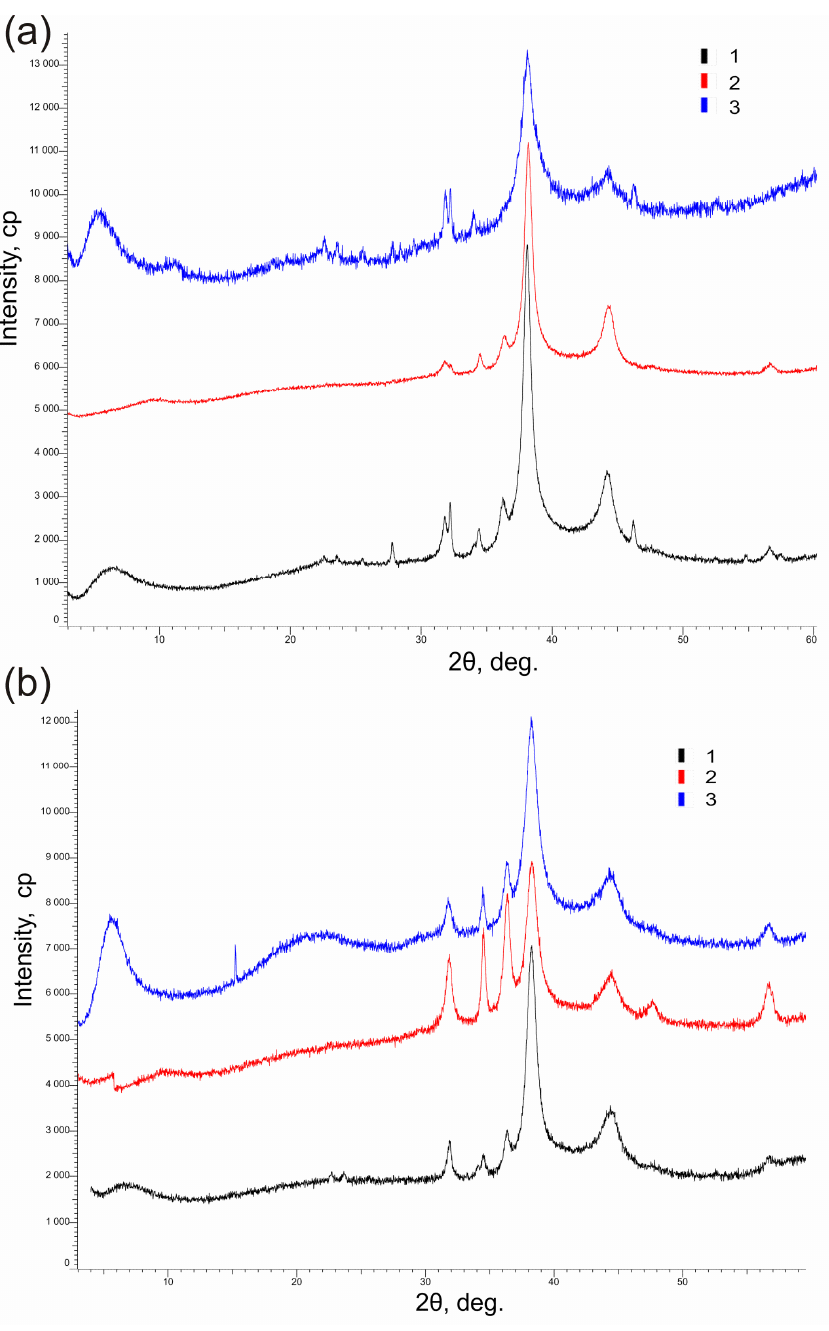
Figure 5. XRD patterns of heterodimers used: ( a ) VM/Ag 0 /ZnO (1), EM/Ag 0 /ZnO (2), Figure 5 . XRD pa tt erns of heterodimers used: ( a ) VM/Ag 0 /ZnO (1), EM/Ag 0 /ZnO (2), SM/Ag 0 /ZnO (3); ( b ) VM/Au 0 /ZnO (1), EM/Au 0 /ZnO (2), SM/Au 0 ZnO (3). SM/Ag 0 /ZnO (3); ( b ) VM/Au 0 /ZnO (1), EM/Au 0 /ZnO (2), SM/Au 0 ZnO